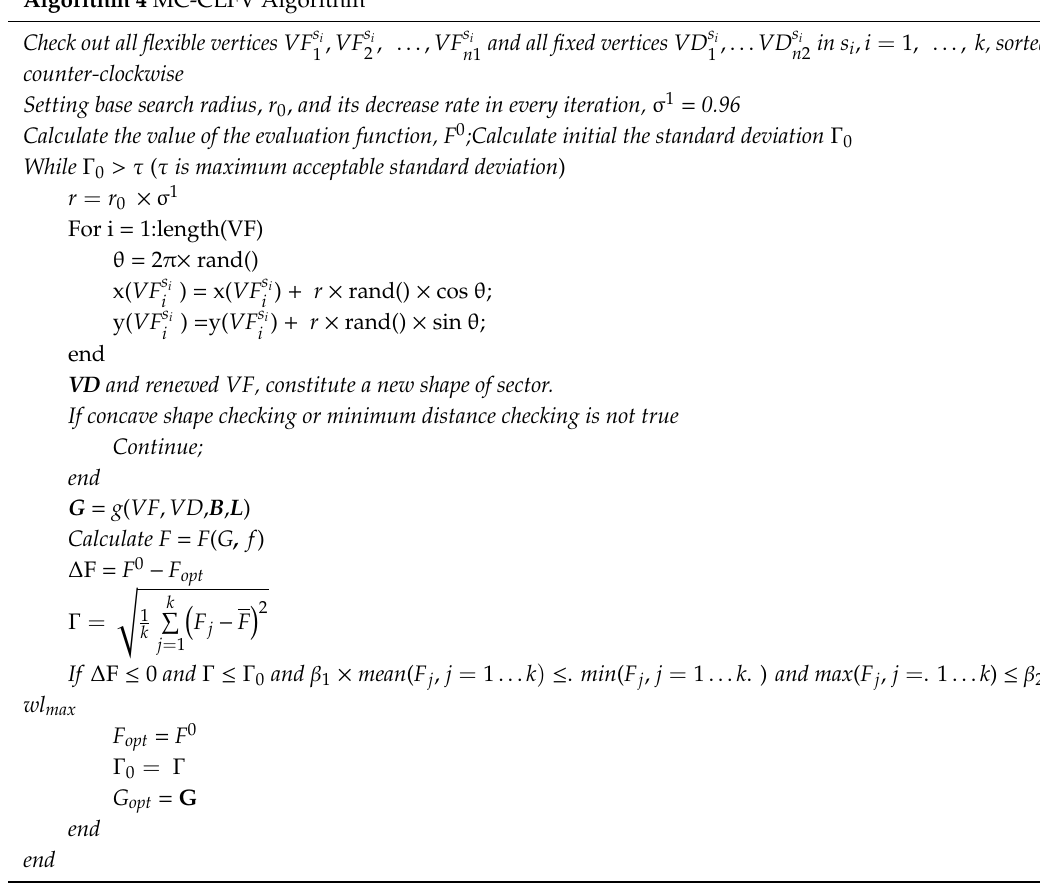
Algorithm 4 MC-CLFV